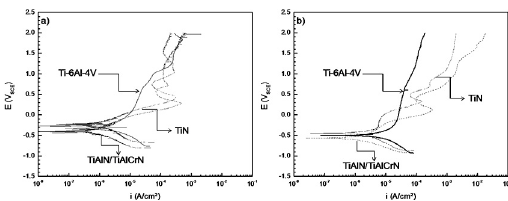
Figure 3. Potentiodynamic polarization curves for uncoated, TiN, and TiAlN/TiAlCrN coated Ti–6Al–4V alloy in 2 M NaOH: a) at 25 °C, b) at 60 °C.